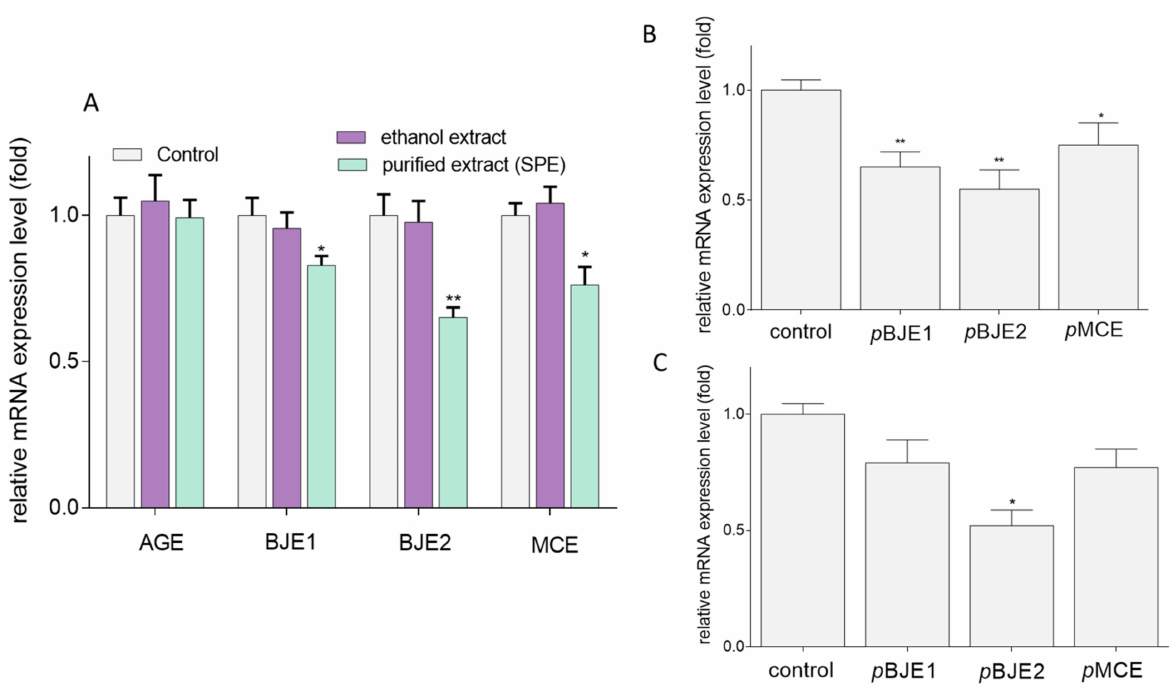
Figure 8. Effect of the ethanolic extracts and the extracts purified with SPE (p) of Apium graveolens (AGE), Brassica juncea 1/2 (BJE1/2), and Matricaria chamomilla (MCE) (0.25 mg/mL) on the mRNA level of GLUT5 ( A ) TXNIP, ( B ) ChREBP, and ( C ) in Caco-2 cells after 24-h incubation determined by real-time PCR and normalized using GAPDH as a reference gene; control cells were not exposed to any compound but vehicle; values are means ± standard deviations, n ≥ 4; statistical significance was calculated versus control cells (untreated), * p ≤ 0.05, ** p ≤